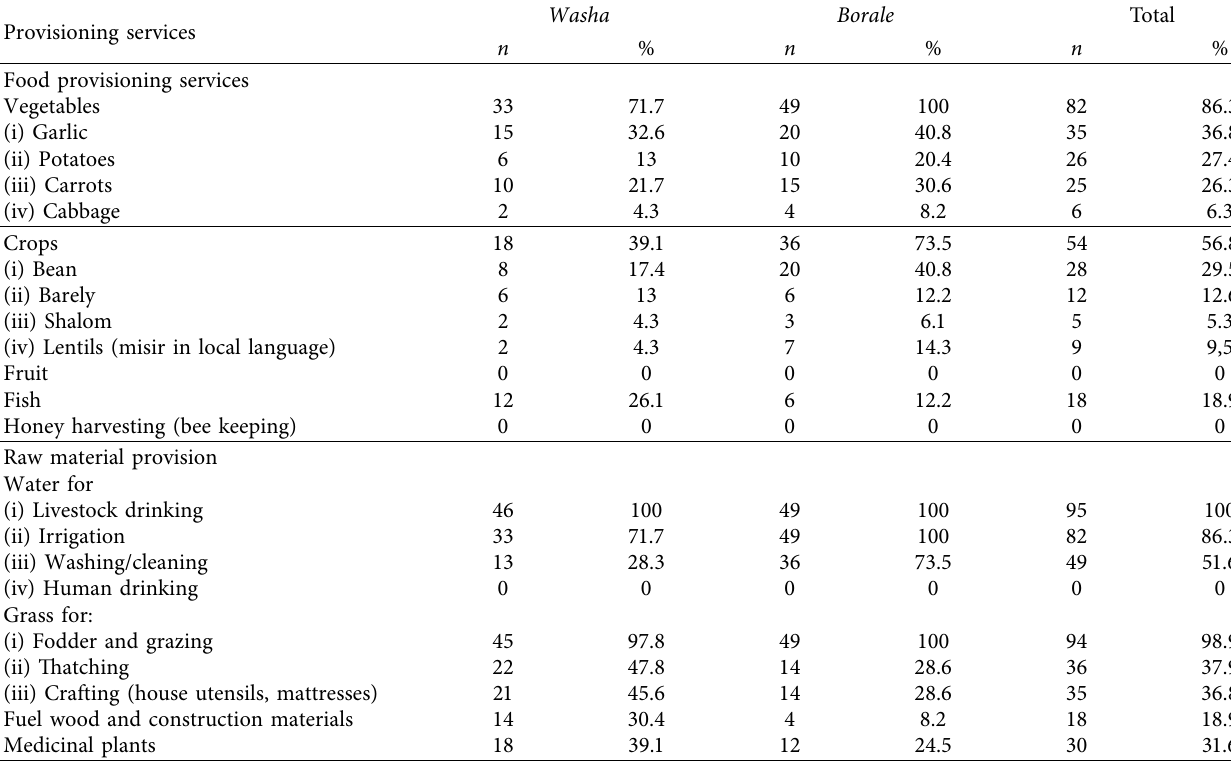
Table 8: Provisioning services provided by the study sites using the household survey.